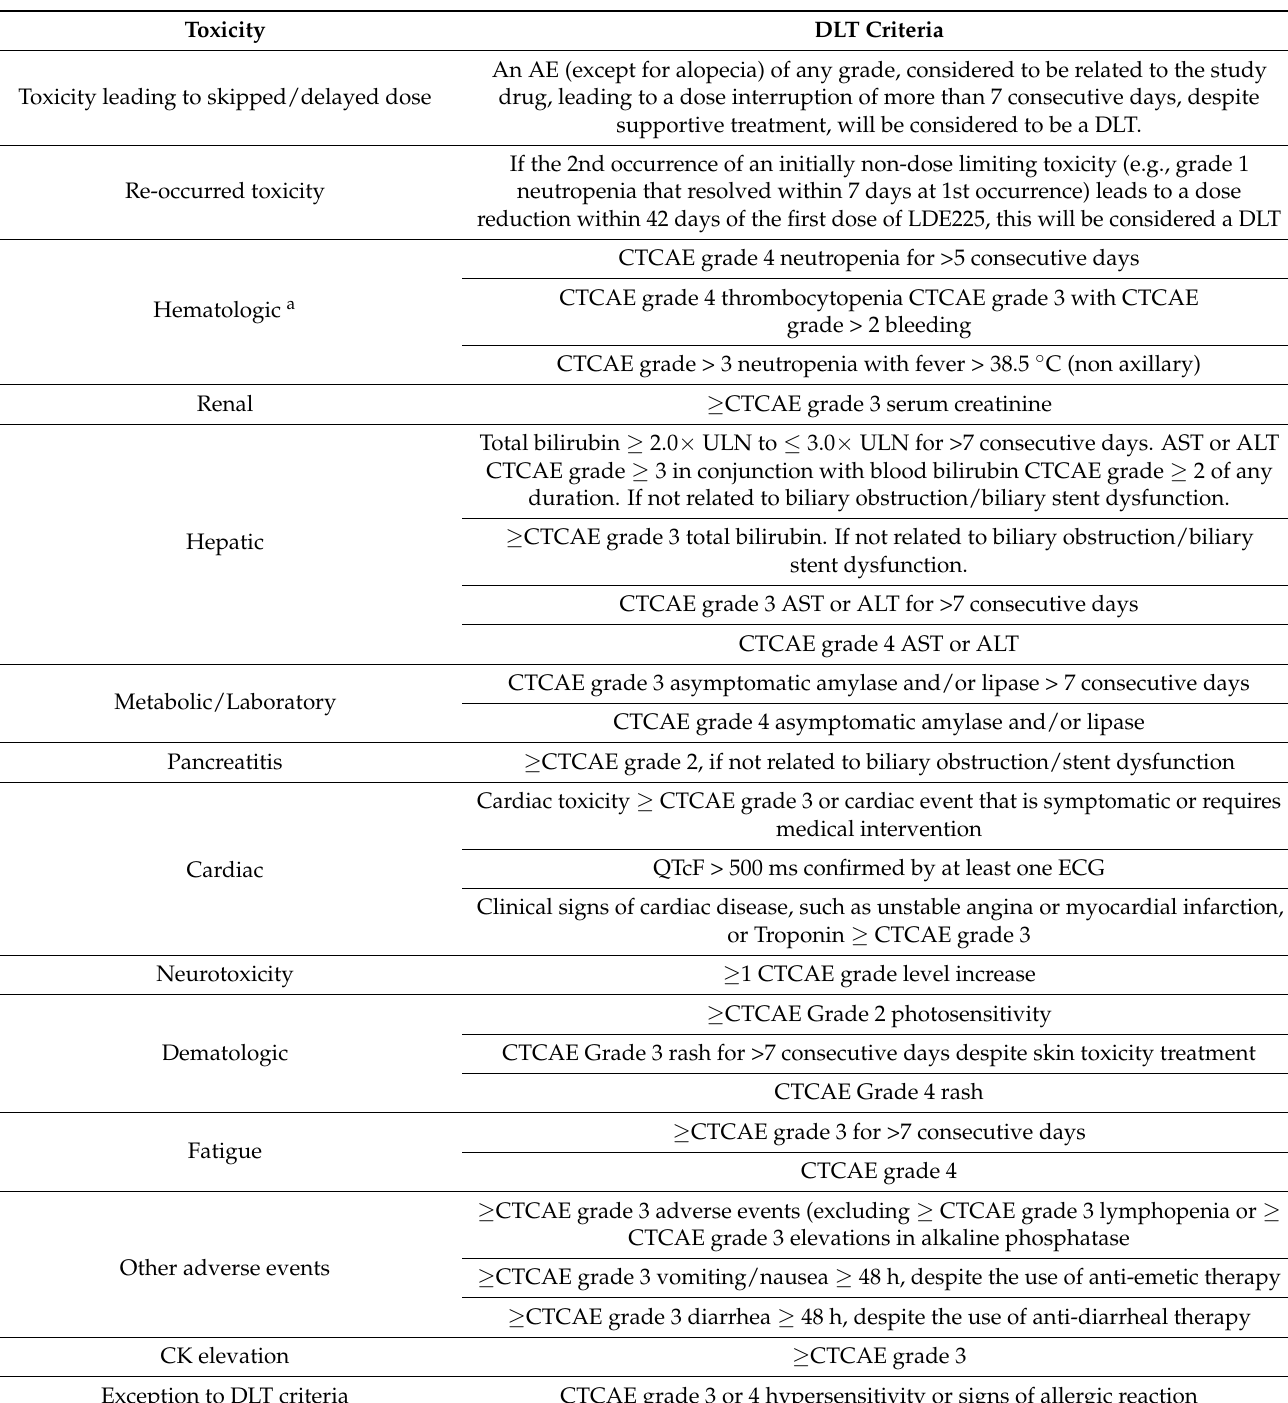
Table 1. Criteria for defining dose-limiting toxicities